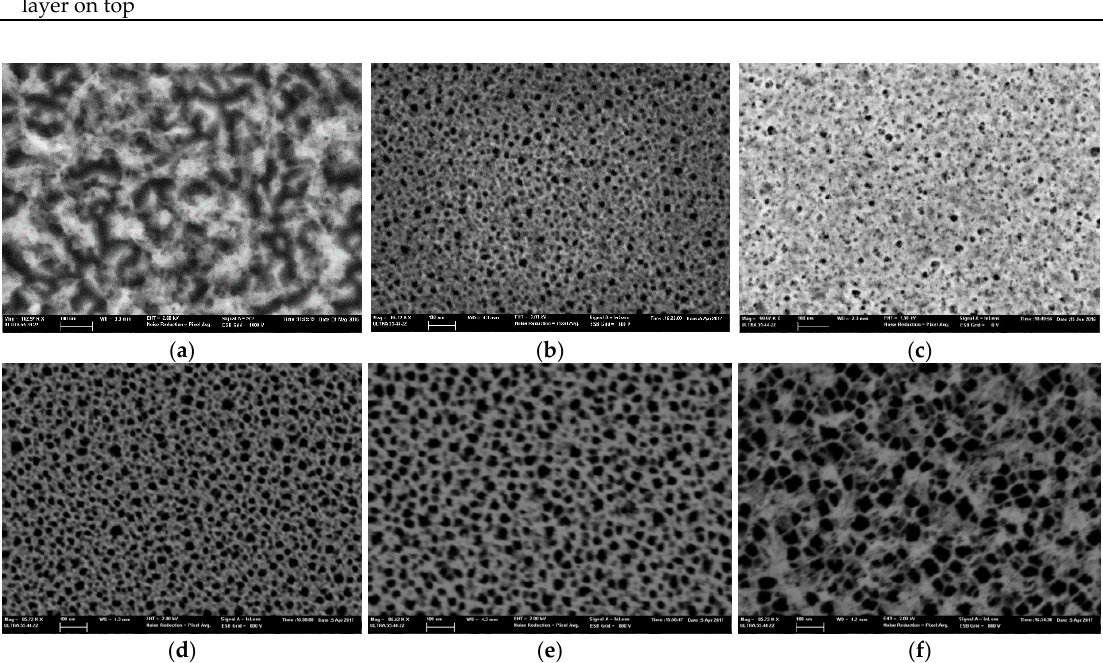
Figure 1. Field emission scanning electron microscopy (FESEM) images of electrochemically etched p-type Si 0.01–0.02 Ω∙ cm ( a ) hydrofluoric acid (HF):ethanol (EtOH) 1:9, I = 22 mA/cm 2 , T = 90 s, ( b